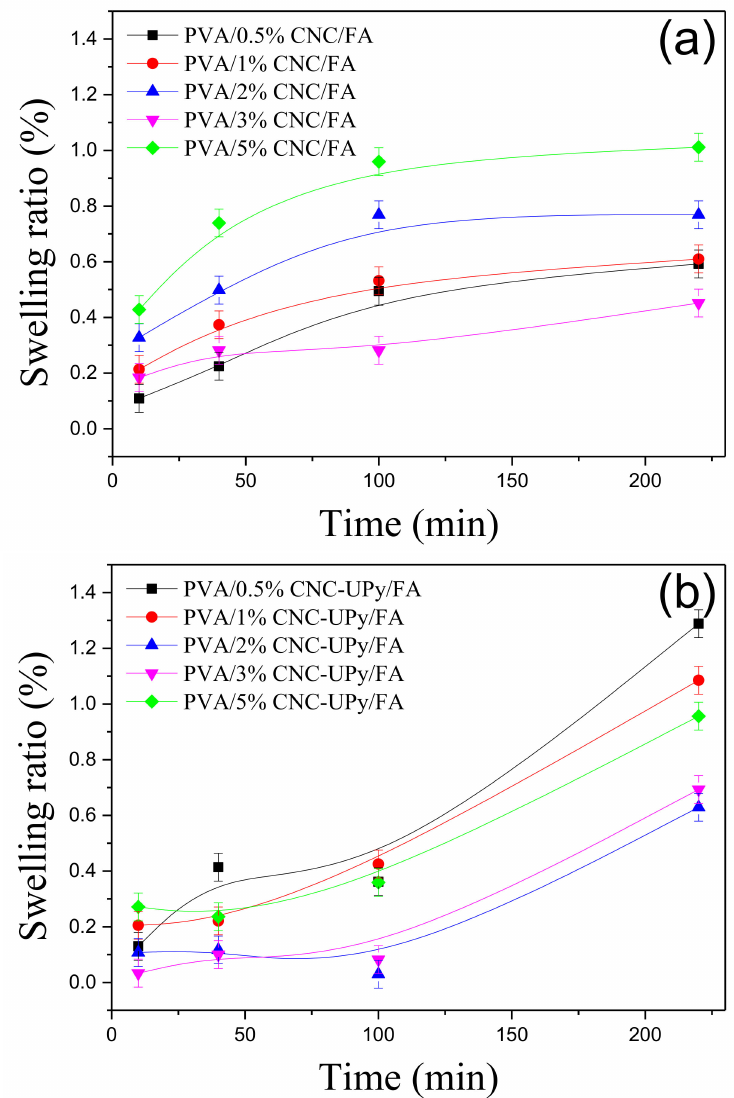
Figure 10. Swelling ratio of di ff erent PVA composite hydrogels ( a ) PVA / CNC / FA, ( b ) PVA / CNC-UPy /